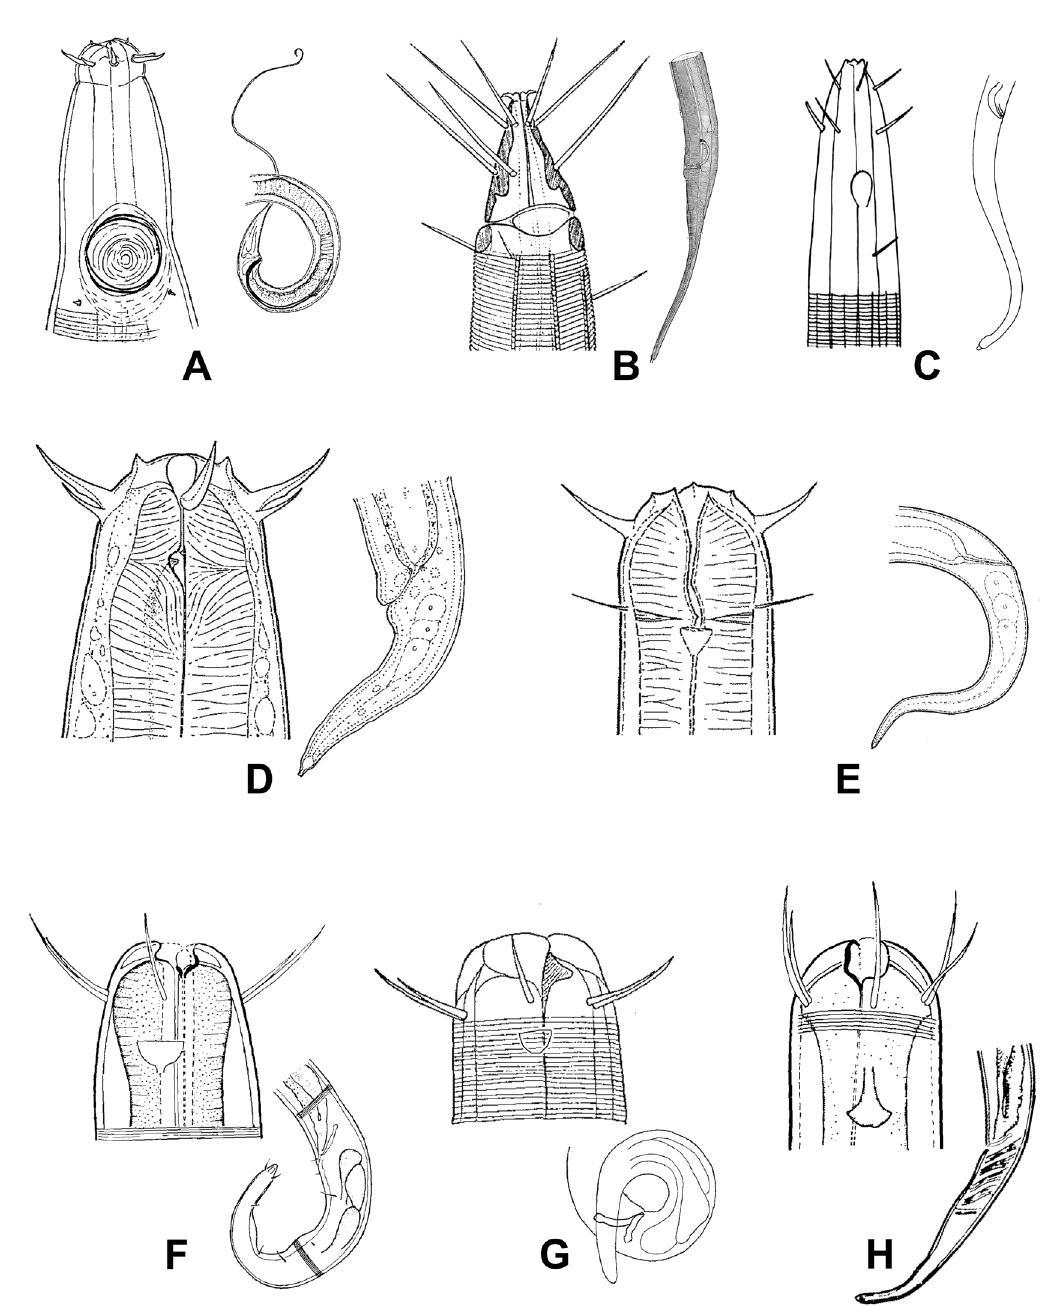
Fig. 9. Anterior and posterior body regions of Trefusiina genera (members of the families Simpliconematidae, Xennellidae, Trischistomatidae and Lauratonematidae) (continued on next page). A . Simpliconema aenigmatoides Blome & Schrage, 1985. B . Xennella suecica Allgén,